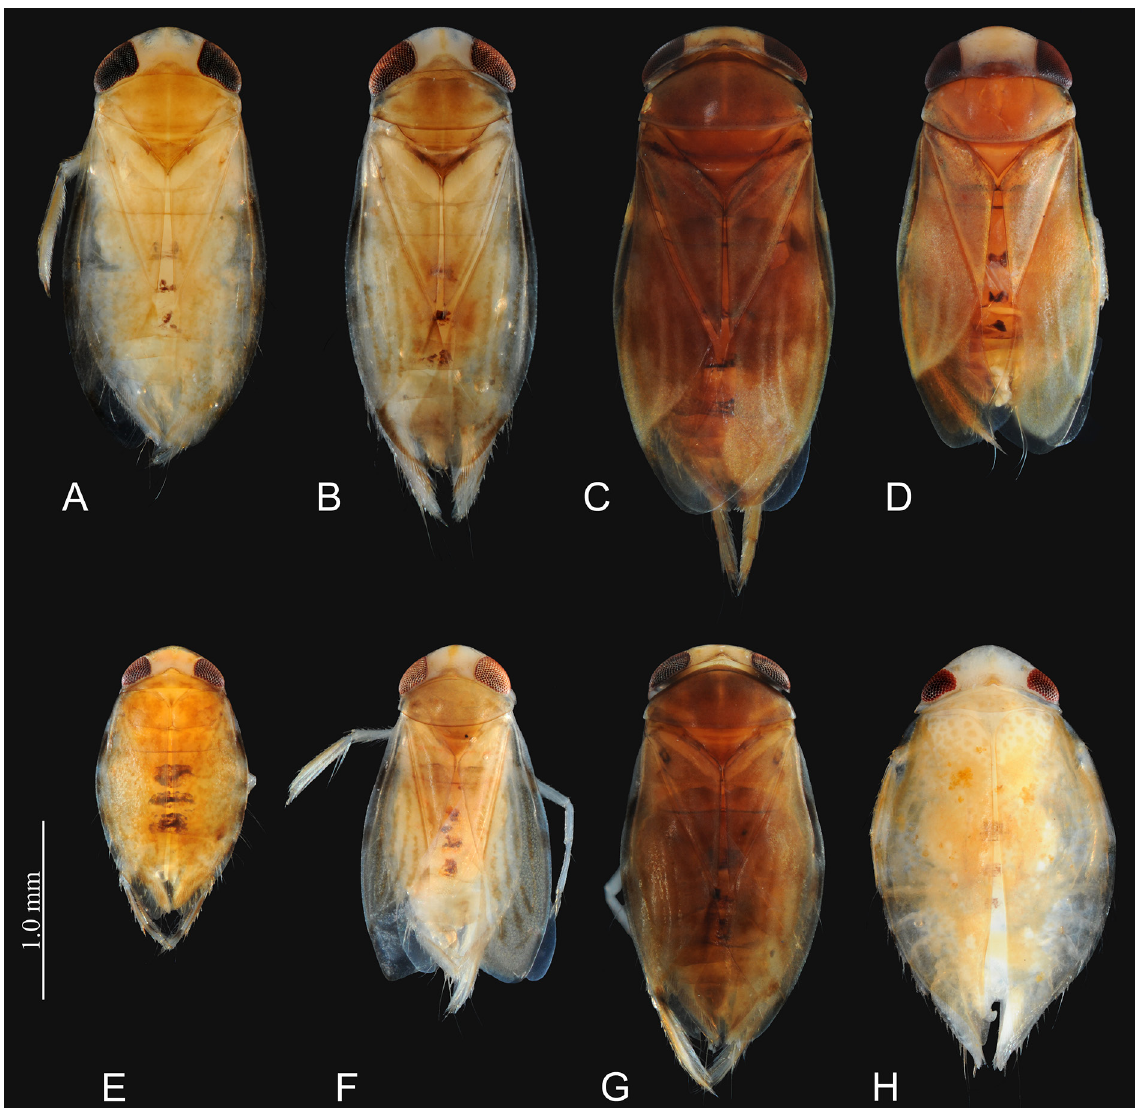
Fig. 21. Habitus photos of species of Micronecta Kirkaldy, 1897 and Synaptonecta Lundblad, 1933, ♂♂. A . M. quadristrigata Breddin, 1905 (ZVNU). B . M. altera Wróblewski, 1972 (ZVNU). C . M . polhemusi Nieser, 2000 (ZRC). D . M. melanochroa Nieser, Chen & Yang, 2005 (ZVNU). E . M. caperata sp. nov., holotype (ZVNU). F . M. fugitans Breddin, 1905 (ZVNU). G . M. tarsalis Chen, 1960 (ZVNU). H . S. issa (Distant, 1910) (ZVNU). All to the same